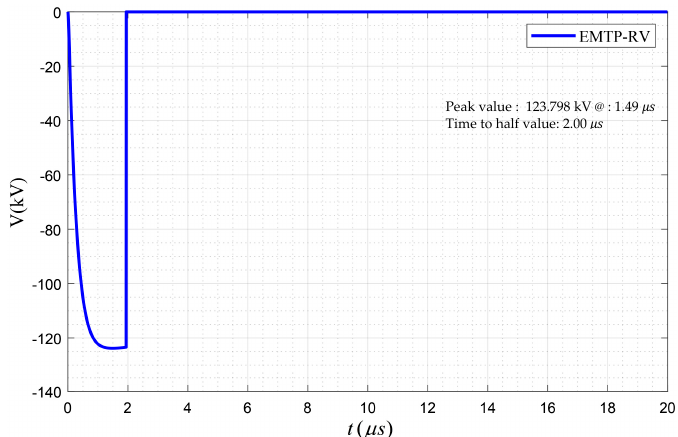
Figure 20. Applied impulse 125 kV in the presence of the 5 μH filtered spark gap, EMTP-RV model.